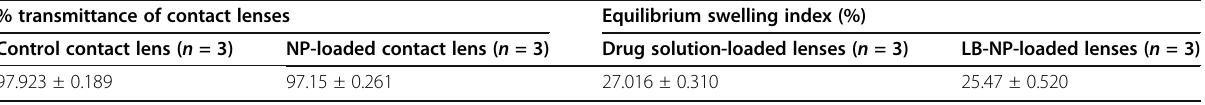
Table 5 Percentage transmittance and ESI of the contact lens